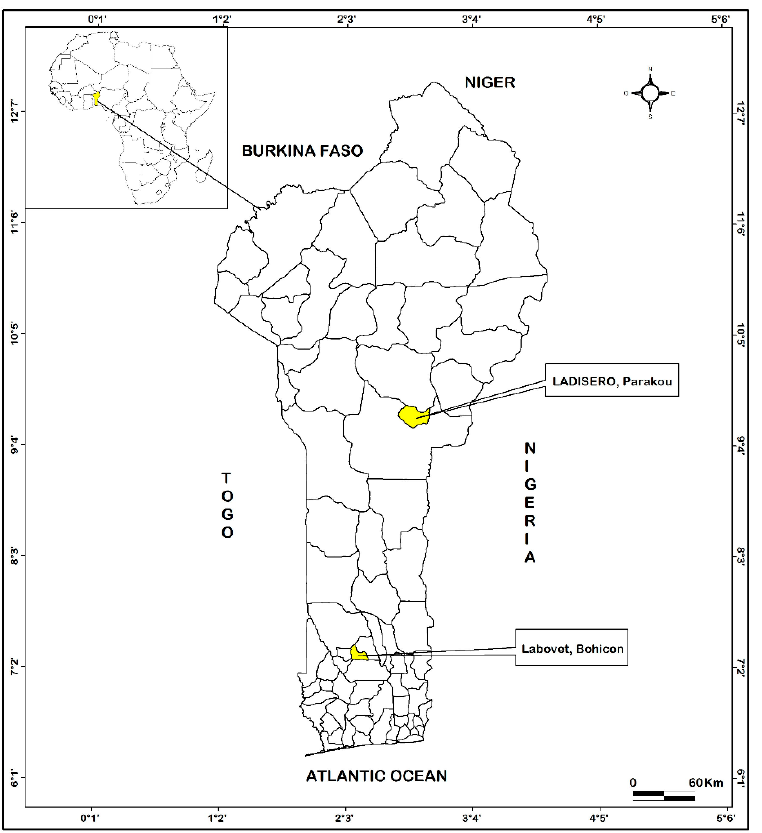
Figure 1: Geographical position of veterinary laboratories in Benin Republic in February 2021. Figure 1. Geographical position of veterinary laboratories in Benin Republic in February